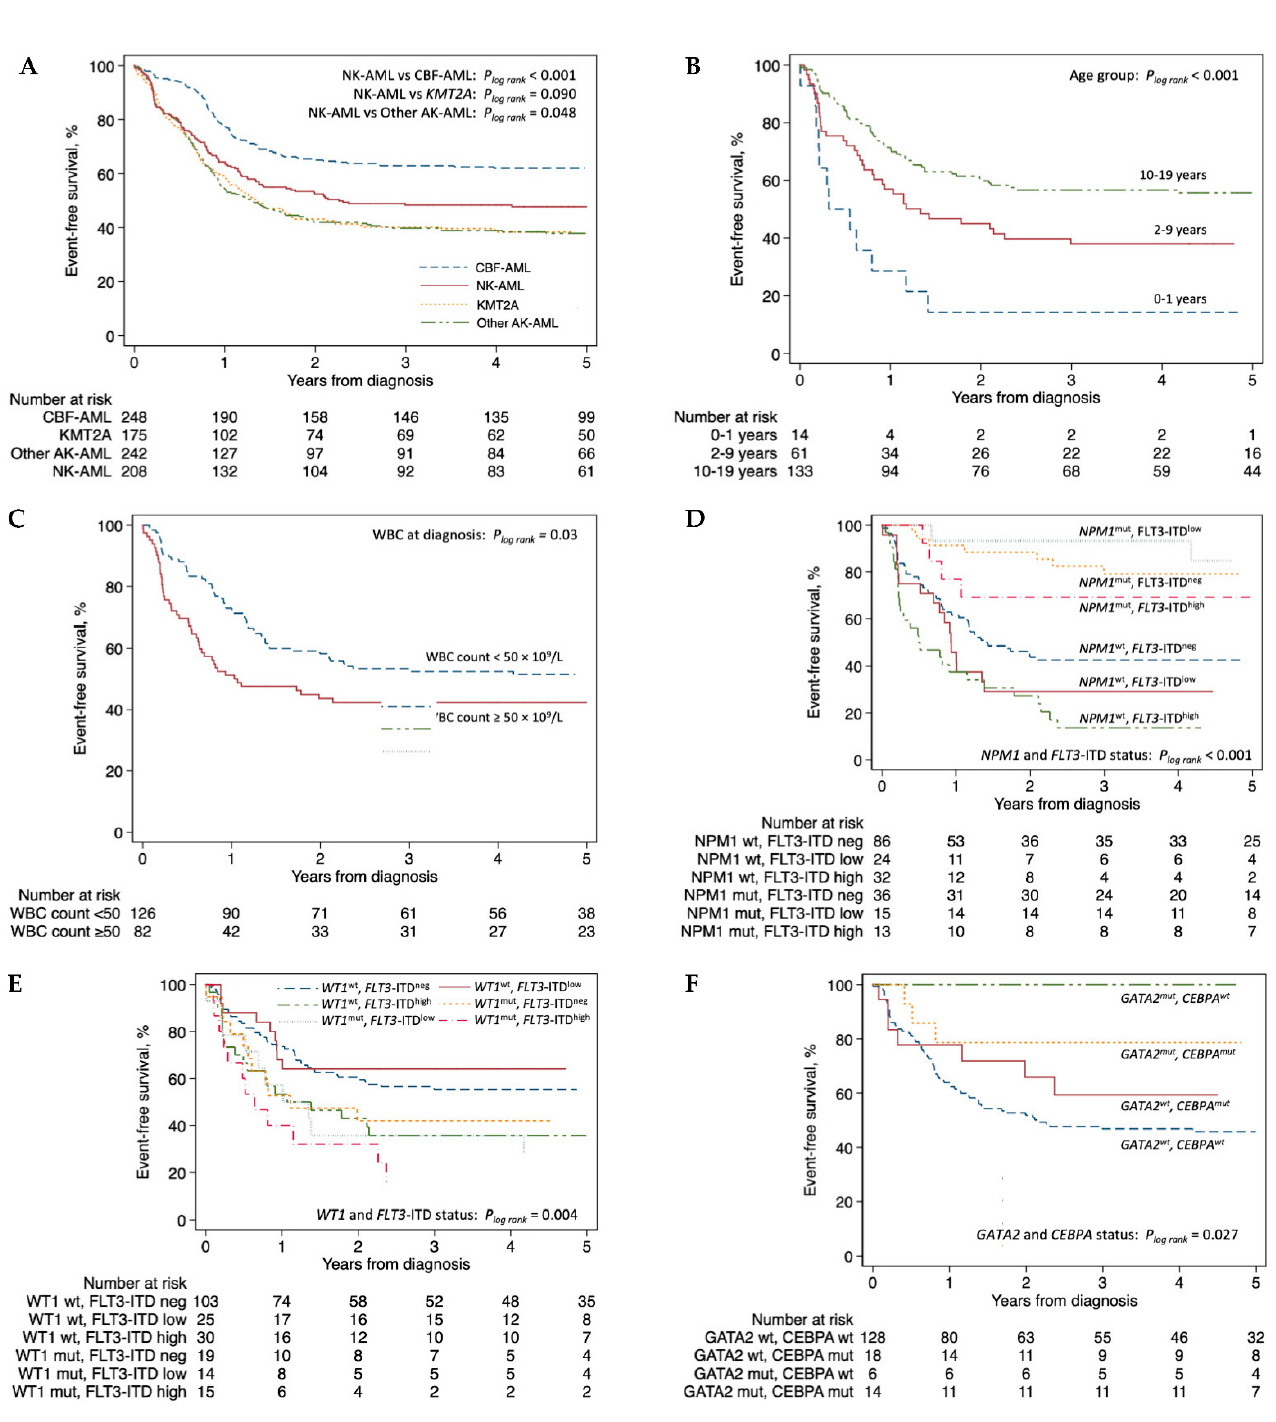
Figure 4. Kaplan-Meier curves of event-free survival by ( A ) cytogenetic group (entire TARGET-AML cohort), ( B) age group, ( C ) WBC count at diagnosis, ( D ) NPM1 and FLT3 -ITD status, ( E ) WT1 and FLT3 -ITD status, ( F ) CEBPA and GATA2 status. Panels ( B – F ) are restricted to normal karyotype AML patients alone. Abbreviations: AK-AML, abnormal karyotype AML; CBF-AML, core-binding factor AML; ITD, internal tandem duplication; KMT2A, KMT2A rearranged AML; mut, mutation; neg, negative; NK-AML, normal karyotype AML; pos, positive; WBC, white blood cell; wt., wildtype. In NK-AML, younger age at diagnosis was associated with inferior EFS ( p <